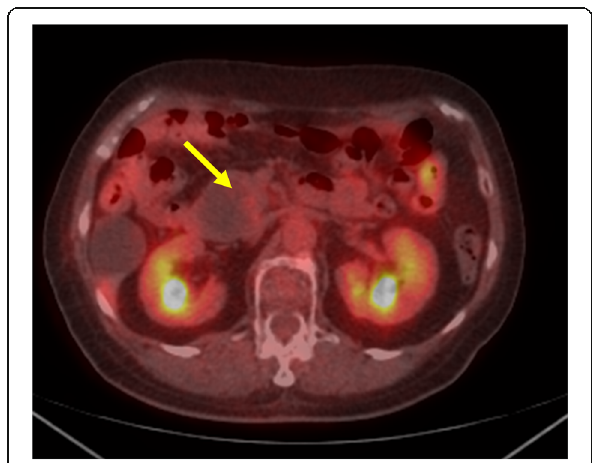
Fig. 3 18 F-Fluorodeoxyglucose positron-emission tomography findings (FDG-PET). FDG-PET showed FDG uptake (SUV max 1.9) in the lesion at the pancreatic head. No evidence of metastasis from other organs was observed